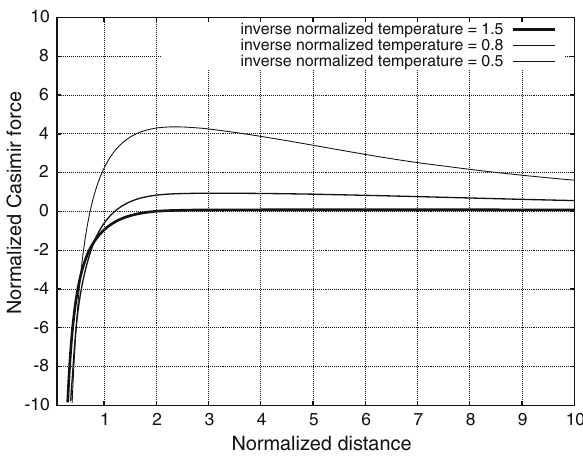
Fig. 3 Normalized Casimir force of a scalar field as a function of nor- malized separation for different normalized temperatures. ¯ m is set equal to 1